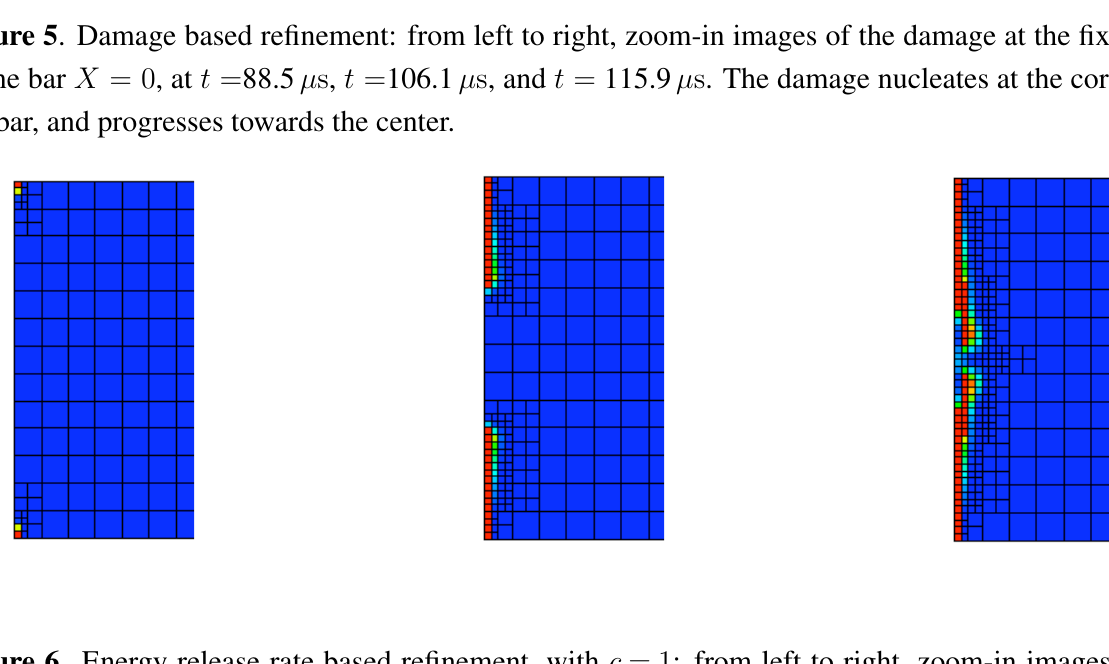
Figure 6 . Energy release rate based refinement, with c = 1 : from left to right, zoom-in images of the damage at the fixed-end of the bar X = 0 , at t = 88.5 µ s , t = 106.1 µ s , and t = 115.9 µ s